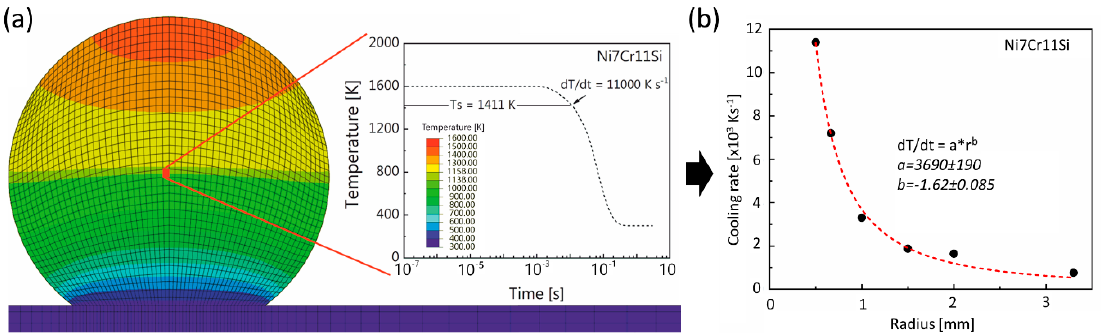
Figure 2. ( a ) Temperature distribution at the cross section of the sphere of 0.5 mm in radius and the temperature profile at the center of the sphere during rapid cooling, ( b ) Cooling rates for Ni7Cr11Si alloys of various sizes .